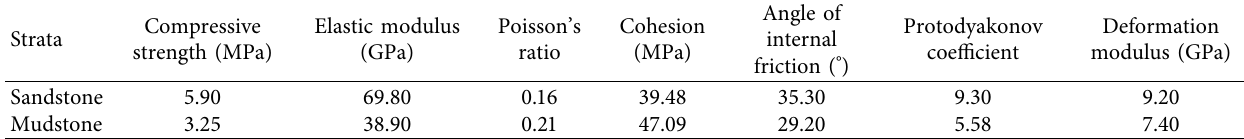
Table 1: Mechanical parameters of rock